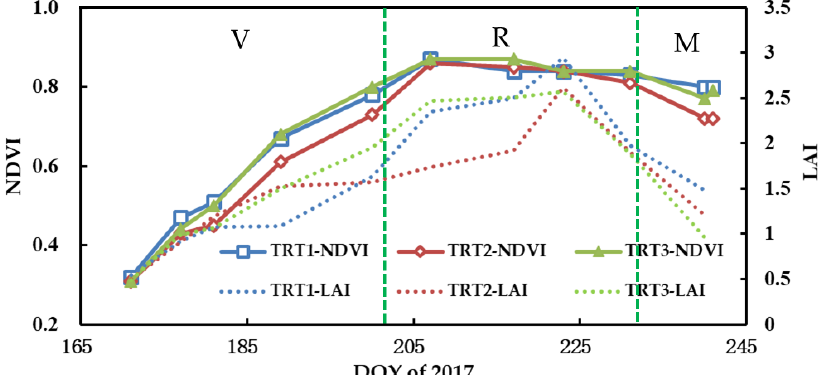
Figure 5. Seasonal variation of NDVI (normalized di ff erence vegetation index) and LAI (leaf area index) under di ff erent treatments during the vegetation to early maturation stages. V, R, and M represent the vegetative, reproductive, and maturation stages, respectively.